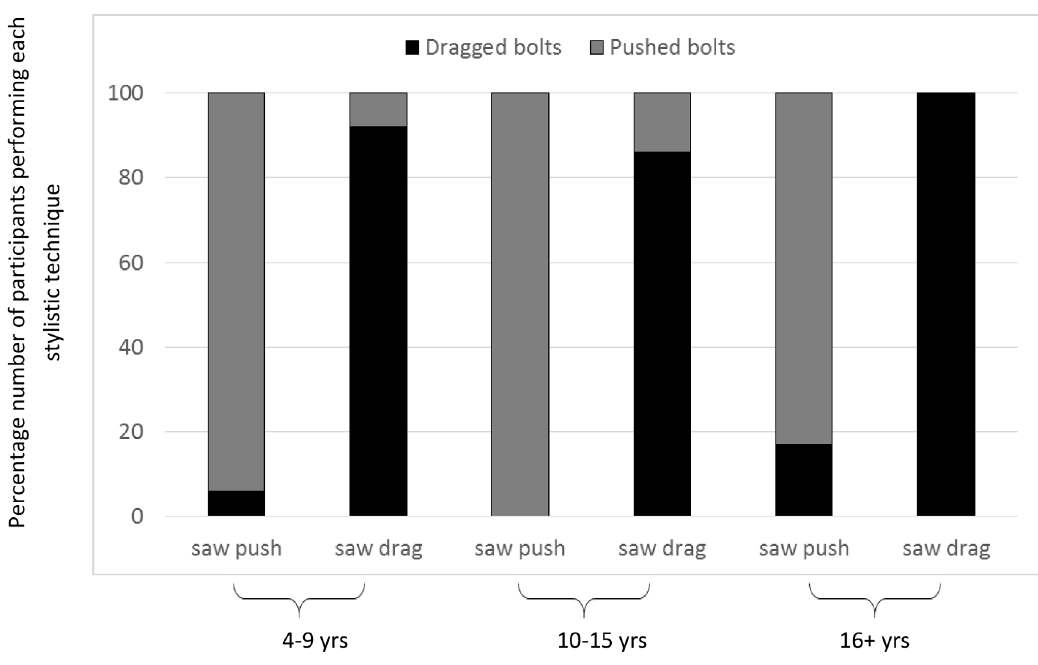
Fig 4. Percentage number of participants in each age group who dragged or pushed the bolts as a function of technique witnessed.